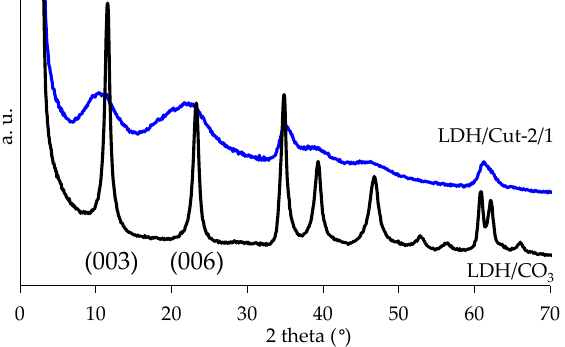
Figure 3. X-ray diffraction patterns of LDH/Cut-2/1, and LDH/CO 3 as a reference sample.